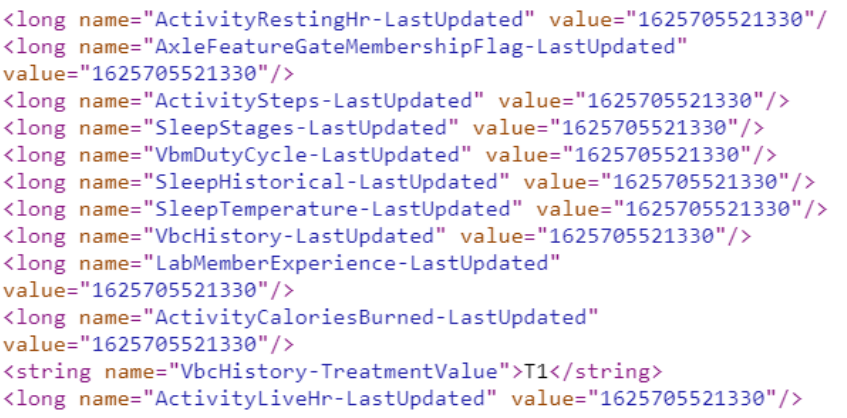
Figure 14. Record showing the timestamps for the last time the Amazon Halo device data were updated, where the timestamp ( 1625705521330 ) corresponds to Wednesday, 7 July 2021 20:52:01 EST